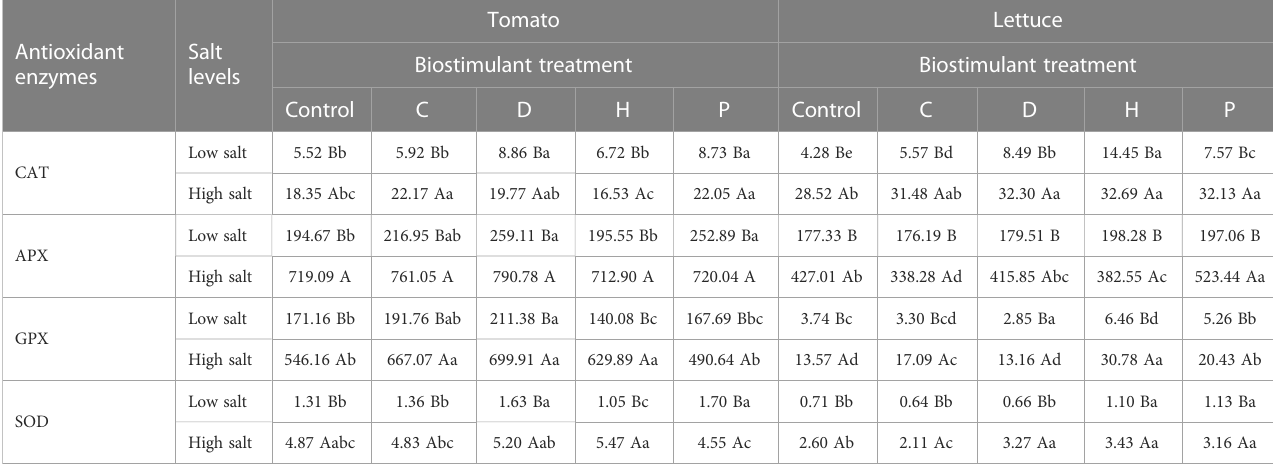
TABLE 2 Effects of salinity stress and protein hydrolysates application on antioxidant enzyme system in tomato and lettuce plants.